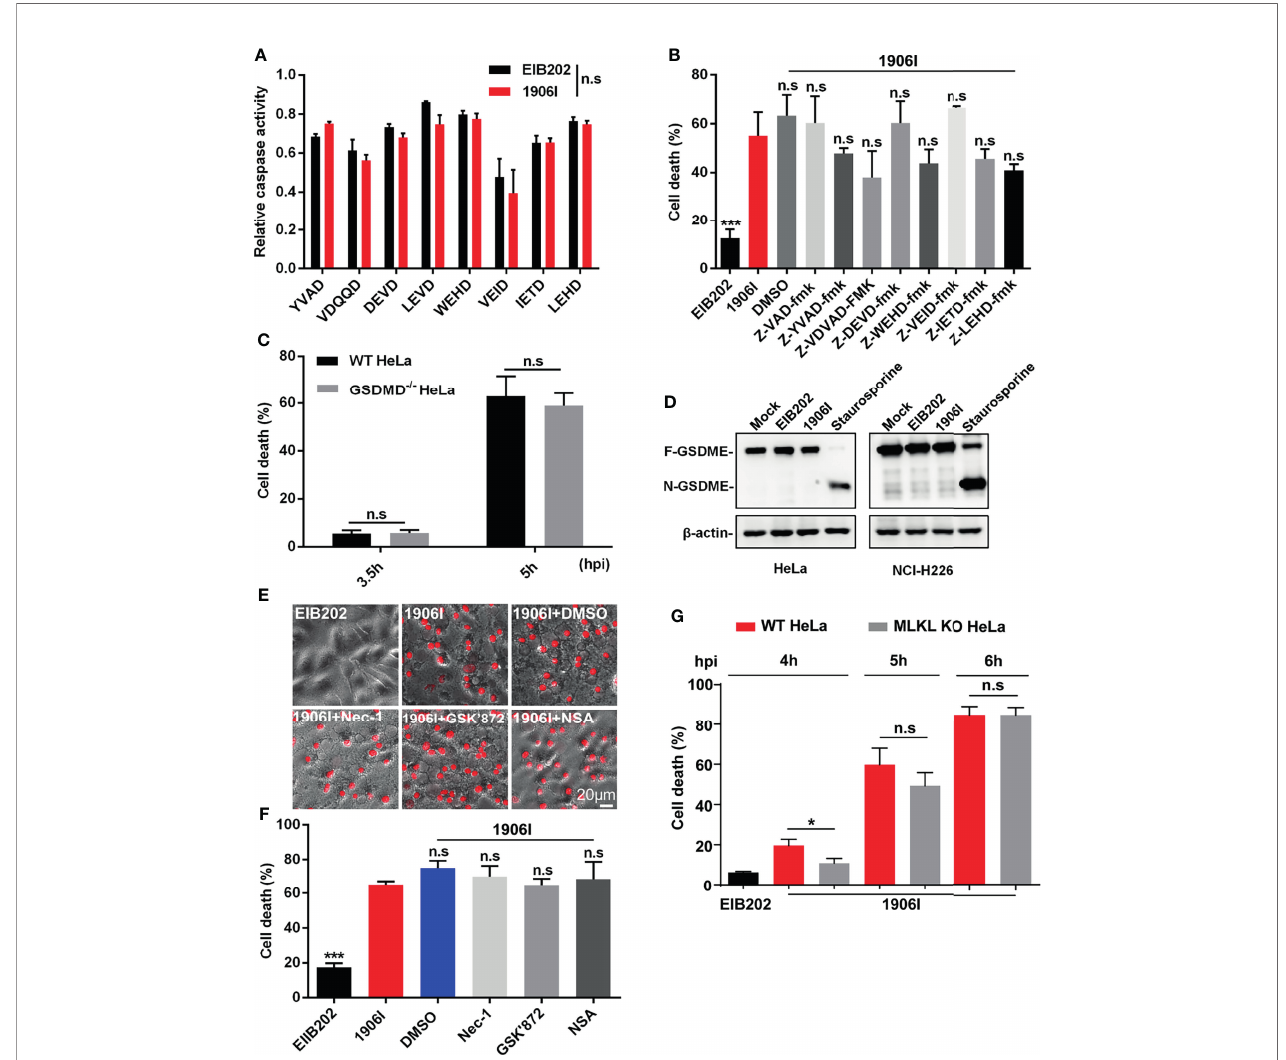
FIGURE 3 | Cell death induced by c-di-GMP-upregulated E. piscicida was independent of caspases, Gasdermin D/E or RIP1/3-MLKL axis. (A) HeLa cells were infected with E. piscicida EIB202 or 1906I (MOI=25, 3.5 hpi). The relative caspase activity was then measured by incubating cell lysate of infected or uninfected cells with chromogenic substrates of caspase-1 (Ac-YVAD-pNA), caspase-2 (Ac-VDQQD-pNA), caspase-3/7 (Ac-DEVD-pNA), caspase-4 (Ac-LEVD-pNA), caspase-6 (Ac- VEID-AFC), caspase-8 (Ac-IETD-pNA) and caspase-9 (Ac-LEHD-pNA), or fl uorogenic substrates of caspase-5 (Ac-WEHD-AFC). (B) HeLa cells were infected with E. piscicida EIB202 or 1906I at an MOI of 25 in the presence of z-VAD-fmk (50 µM), z-YVAD-fmk (50 µM), z-VDVAD-fmk (50 µM), z-DEVD-fmk (50 µM), z-WEHD-fmk (20 µM), z-VEID-fmk (50 µM), z-IETD-fmk (50 µM), z-LEHD-fmk (50 µM), or DMSO. LDH release was detected at 5 h post infection. (C) LDH release of wild-type or gsdmd -/- HeLa cells infected with 1906I strain (MOI=25, 5 hpi). (D) Immunoblots for GSDME cleavage in HeLa or NCI-H226 cells infected with E. piscicida EIB202 or 1906I. HeLa cells treated with staurosporine (20 µM) as a positive control, cells without any treatment as a negative control. (E, F) Cell morphology with PI staining (E) and LDH release (F) of HeLa cells infected with E. piscicida EIB202 or 1906I (MOI=25, 5 hpi) in the presence of necrostatin-1 (Nec-1, 50 µM), GSK ’ 872 (3 µM), necrosulfonamide (NSA, 20 µM), or DMSO. (G) LDH release of wild-type or mlkl -/- HeLa cells infected with E. piscicida EIB202 or 1906I at an MOI of 25 for the indicated time. Scale bar, 20 m m. Results are representative of at least three independent experiments, and error bars denote SD of triplicate wells. * P < 0.05 *** P < 0.001; n.s, not signi fi cant. [Two-way ANOVA for panels (A, C, G) One-way ANOVA for panels (B, F)